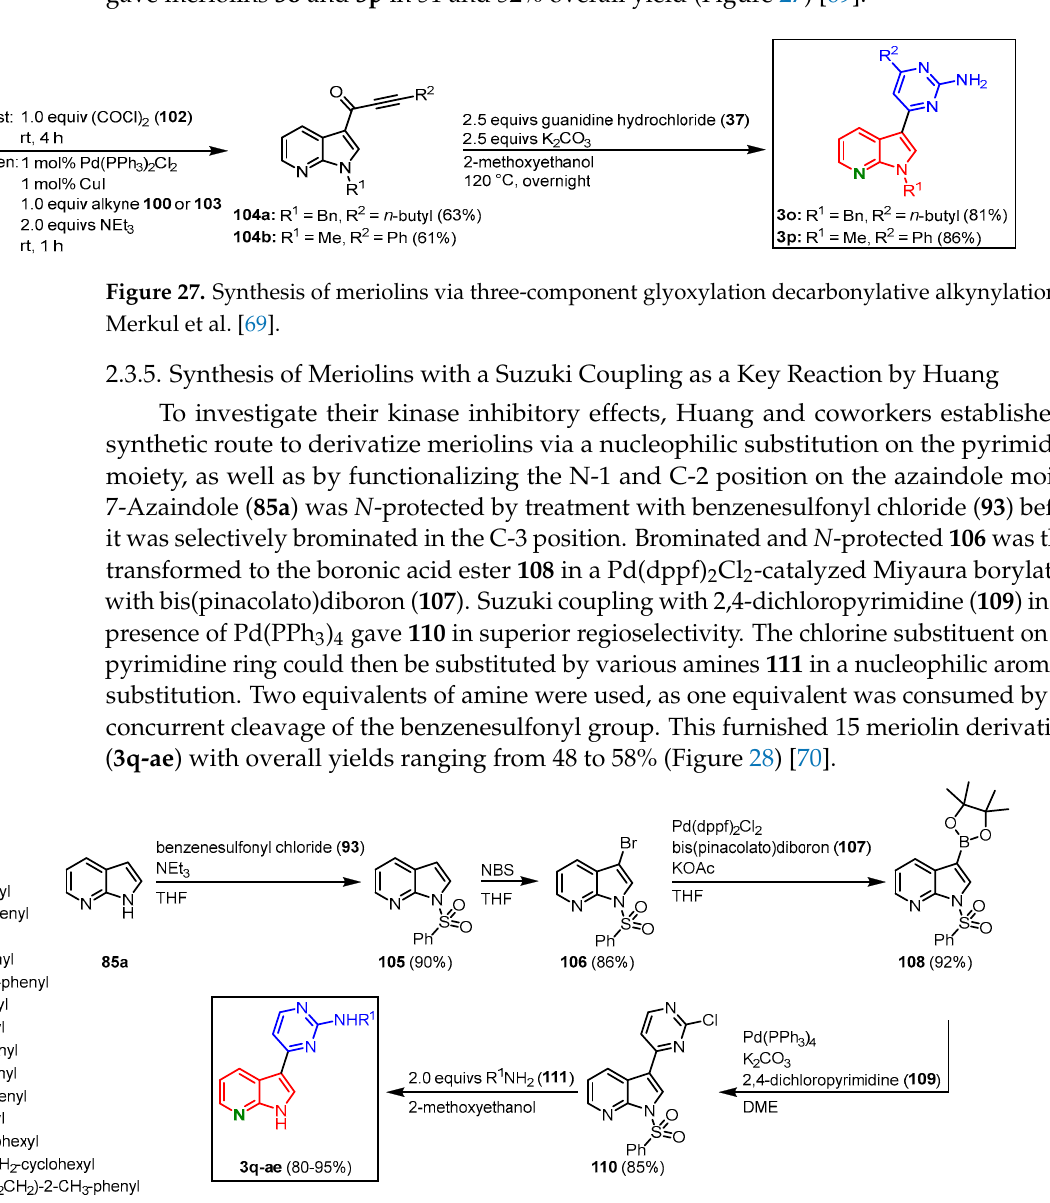
Figure 28. Meriolin synthesis by Huang via nucleophilic substitution on the pyrimidine moiety [70].